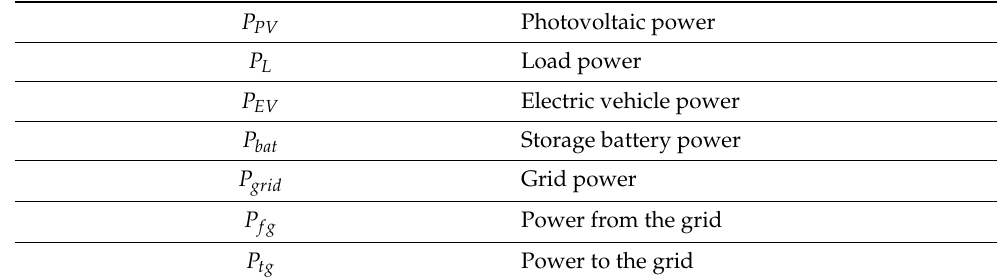
Table 3. Energy system